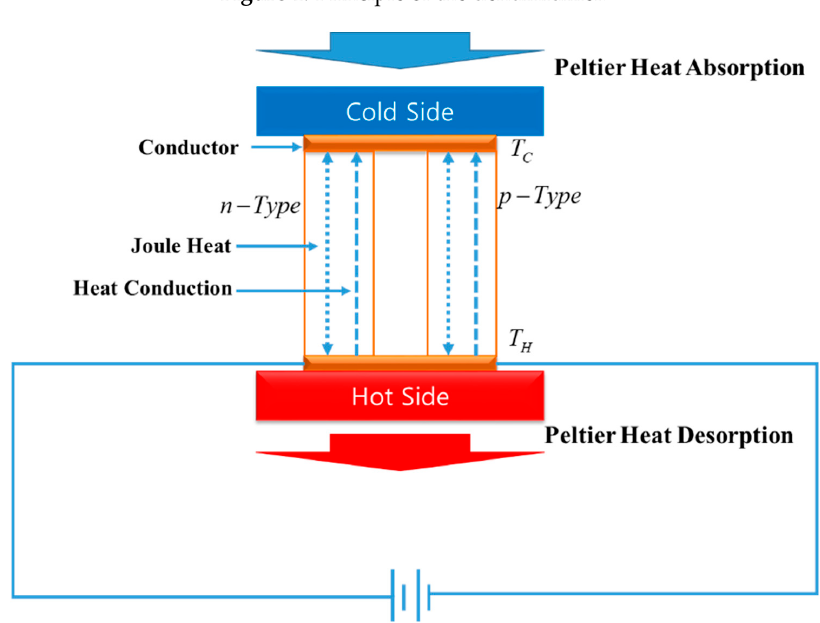
Figure 2. Principle of thermoelectric element.